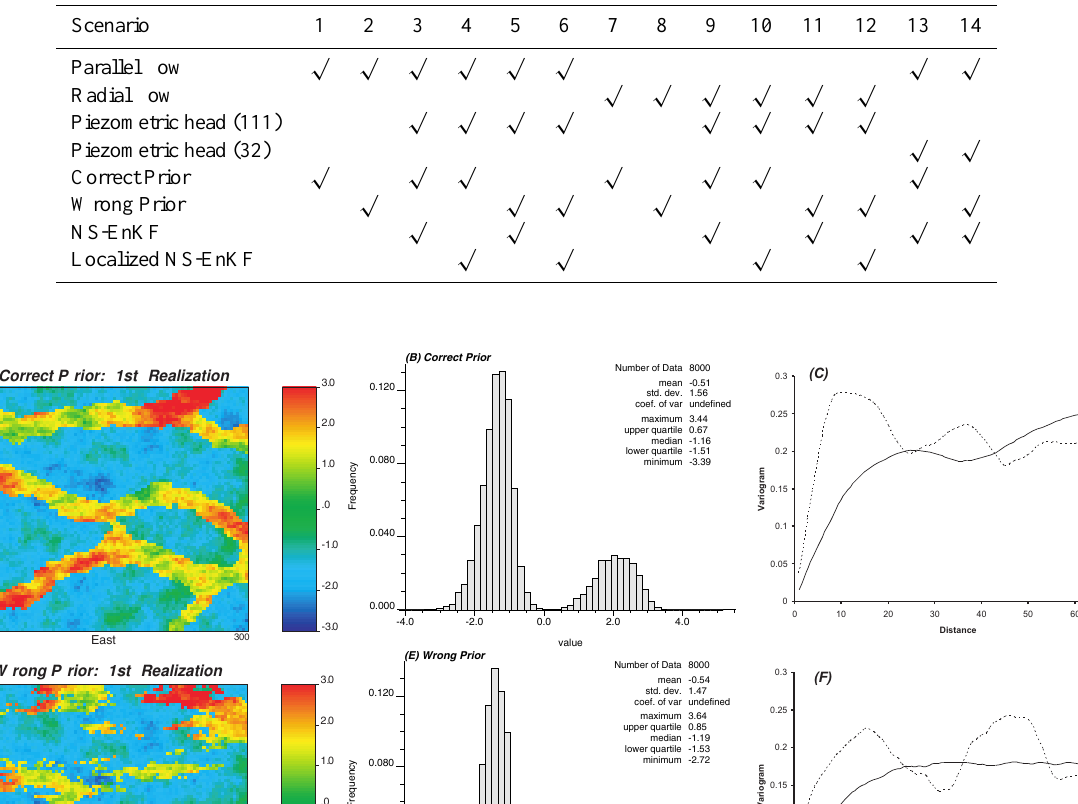
Table 2. Definition of scenarios.